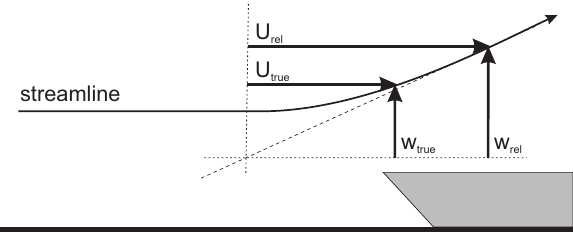
Figure A1. Schematic of the impact of ship horizontal velocity on non-horizontal airflow. The measured horizontal ( U rel ) and vertical ( w rel ) wind components must both be corrected for ship velocity to obtain the true wind components. Not correcting the measured ver- tical wind will result in an incorrect determination of the tilt angle of the flow from horizontal.